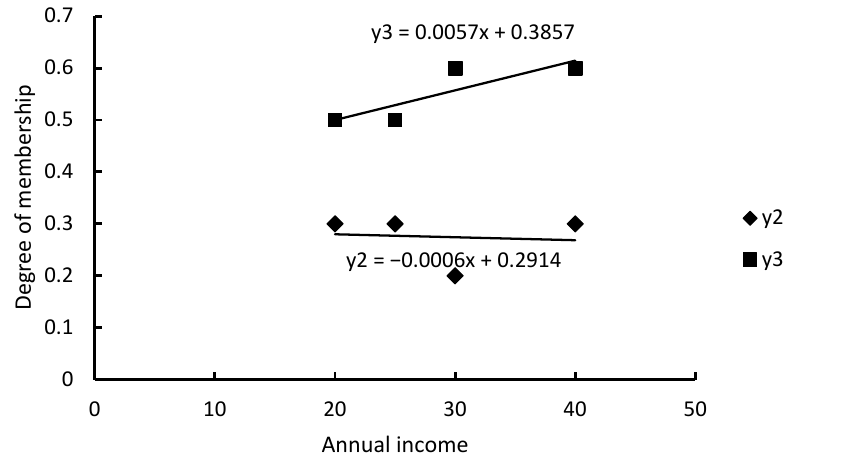
Figure A11. Single factor evaluation for the index of annual income (20–40 (inclusive) ten thou- sand yuan).